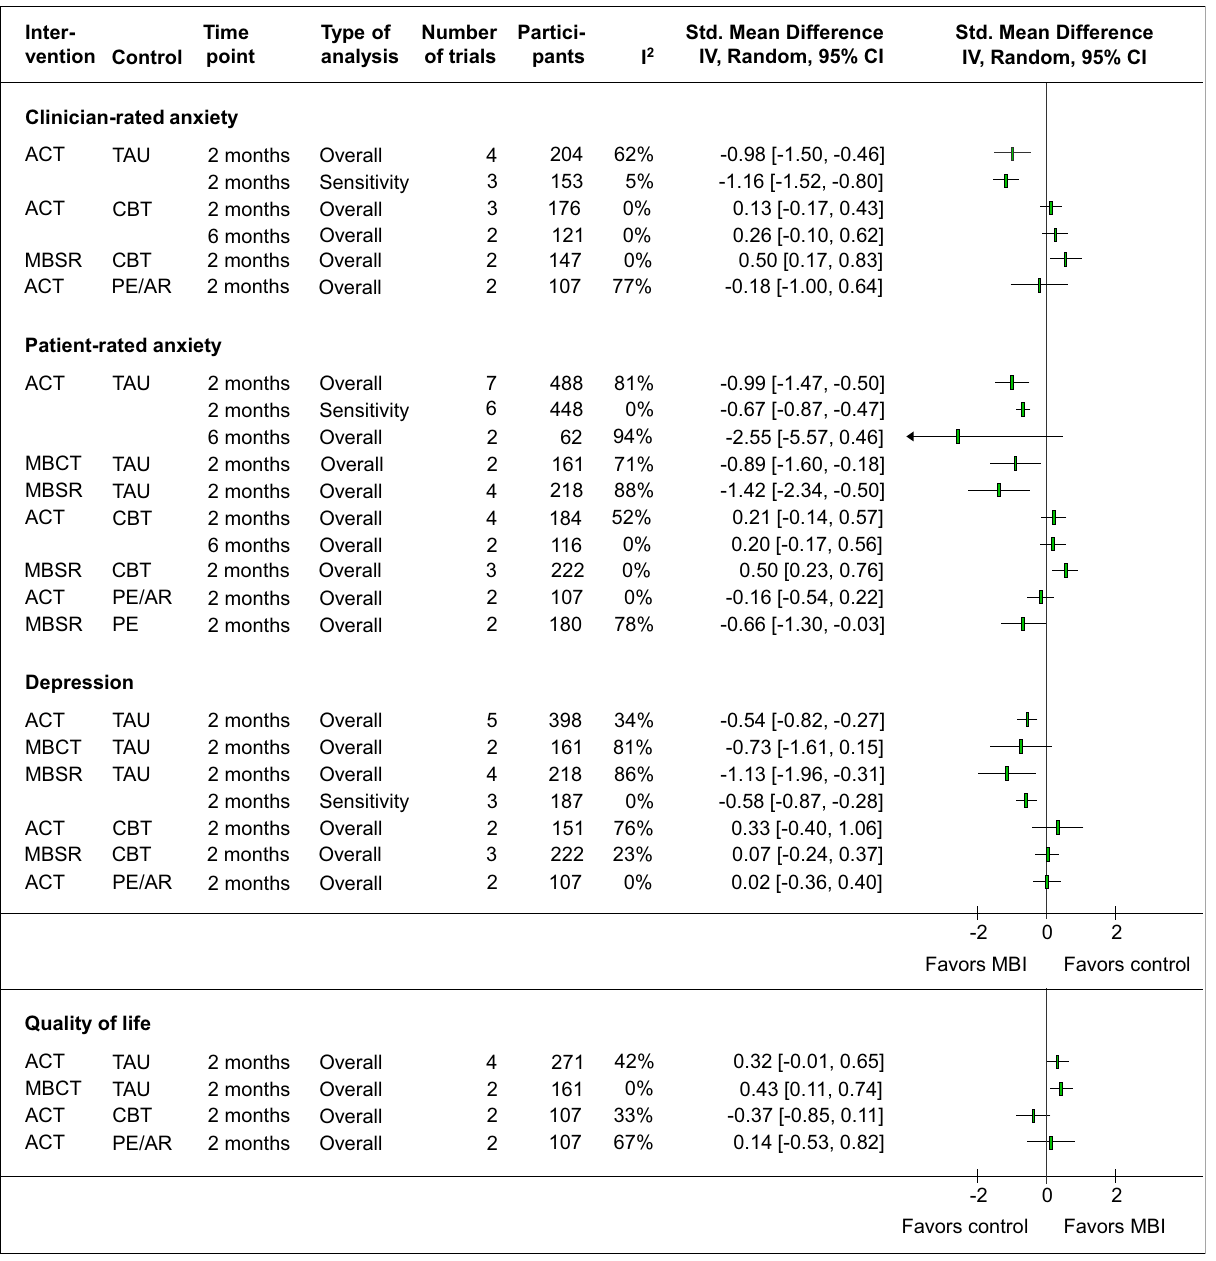
Figure 3. Forest plot summary of the effects on primary and secondary outcomes. Legend. ACT: Acceptance and Commitment Therapy; AR: Applied relaxation; CBT: Cognitive Behavioral Therapy; CI: Confidence interval; I 2 : Measure of statistical heterogeneity; IV: Inverse variance; MBCT: Mindfulness-based Cognitive Therapy; MBSR: Mindfulness-based stress reduction; PE: Psychoeducation; TAU: Treatment as